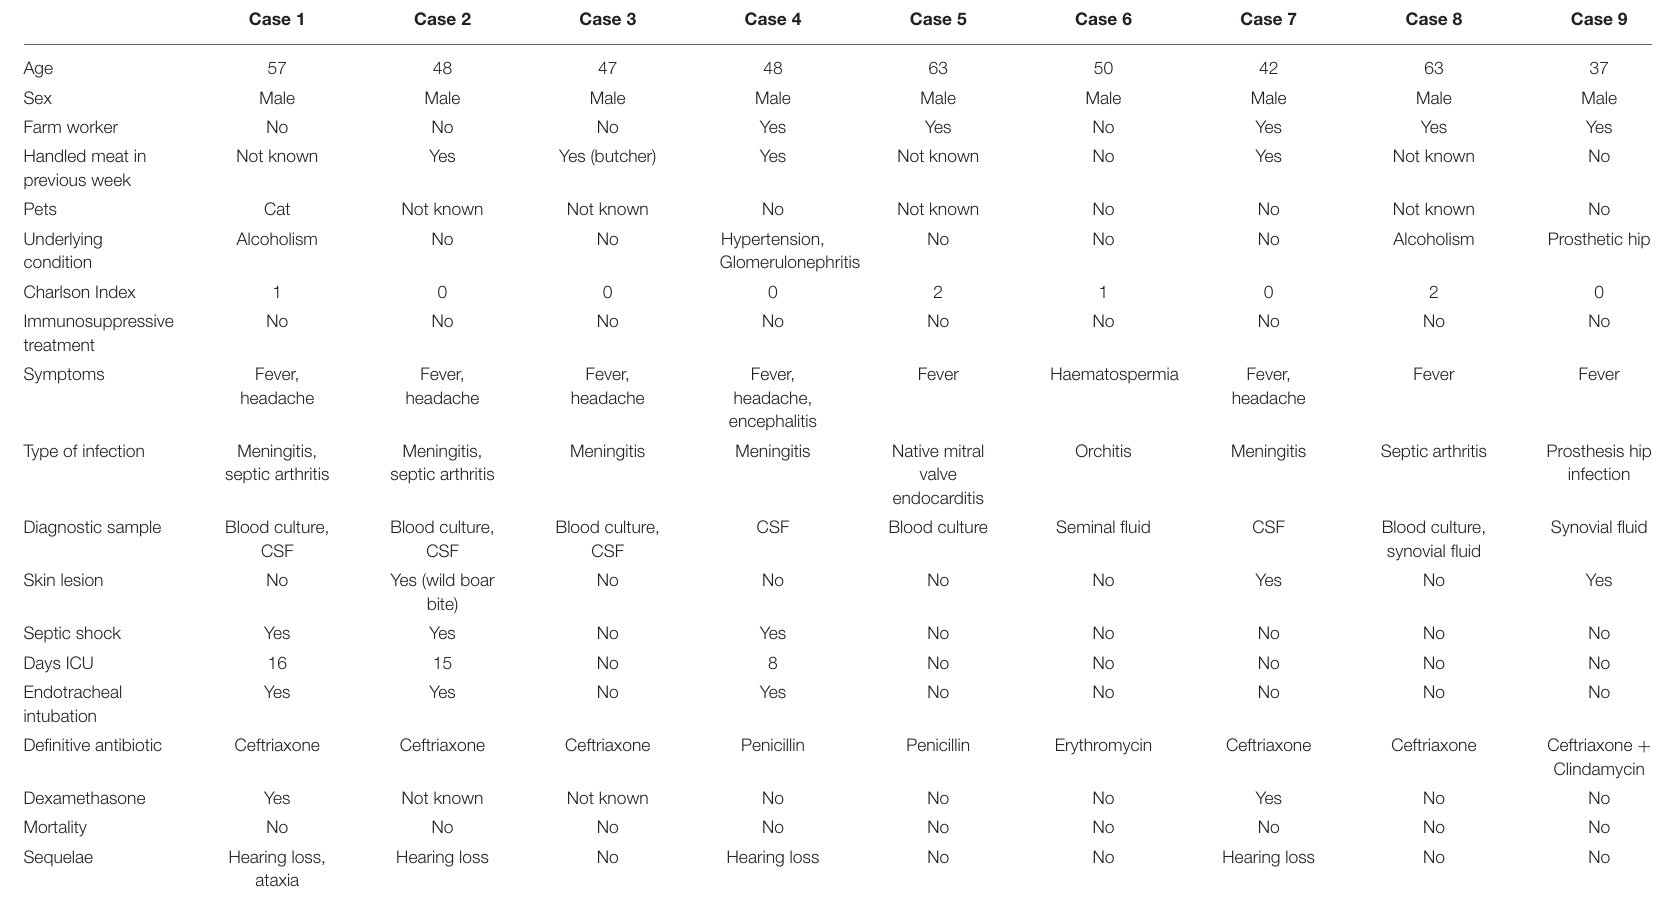
TABLE 1 | Clinical and epidemiological characteristics of cases of S. suis